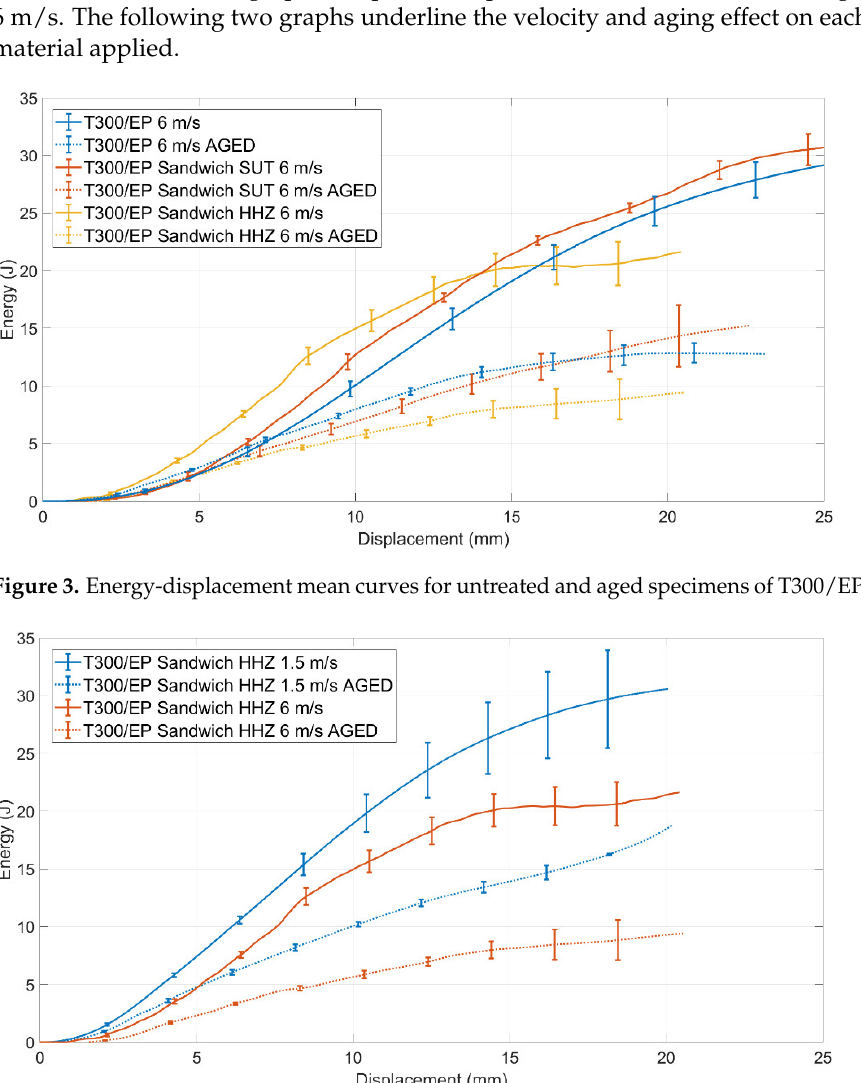
Table 4. Averaged results with the standard deviation of the impact tests.